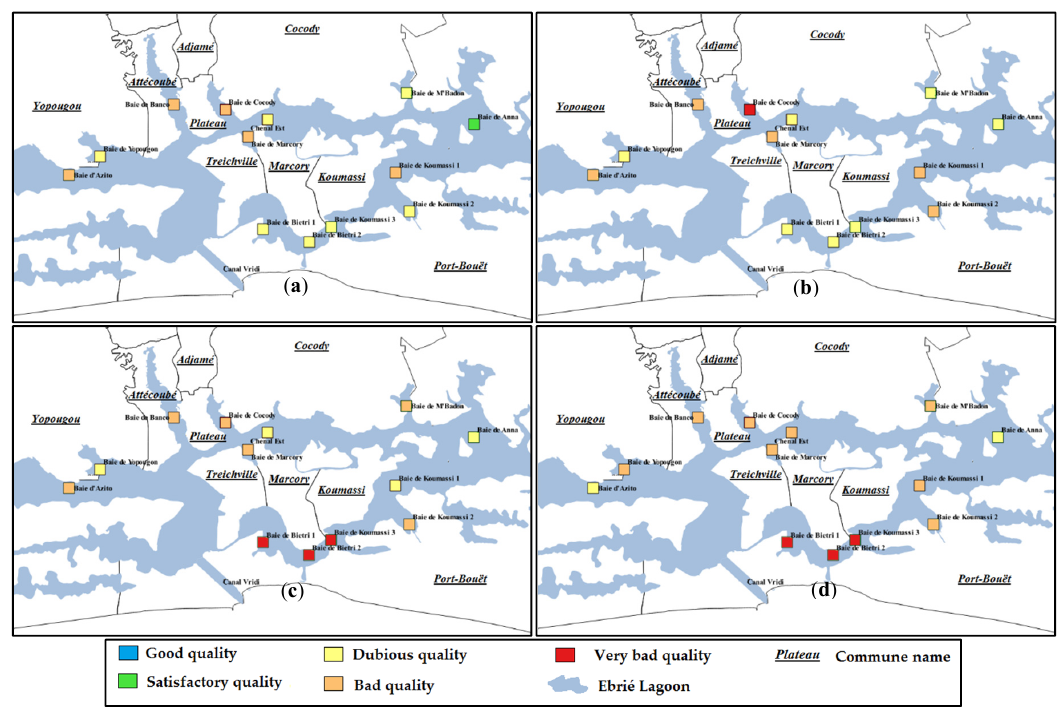
Figure 4. Spatio ‐ temporal variation of the Water Quality Index for sports and recreation: ( a ) June 2014